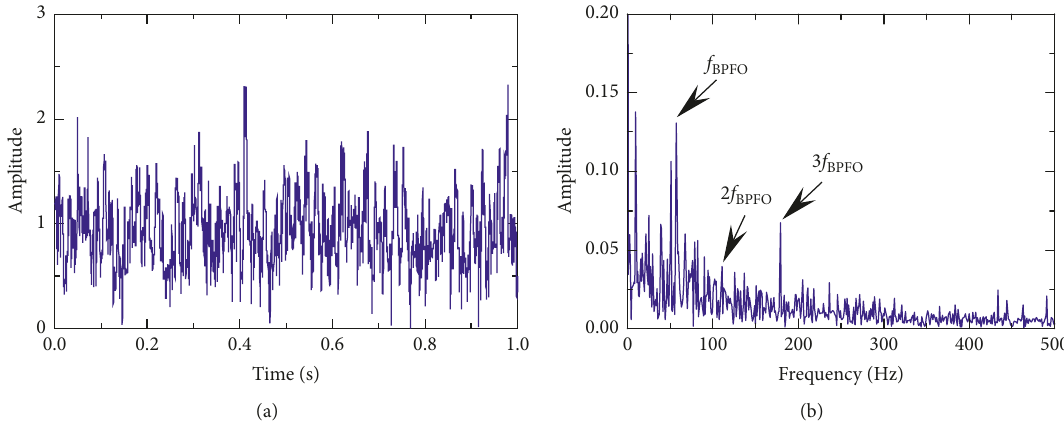
Figure 21: Case 2: waveform and spectrum of traditional MMF filtering result: (a) time-domain waveform; (b) amplitude